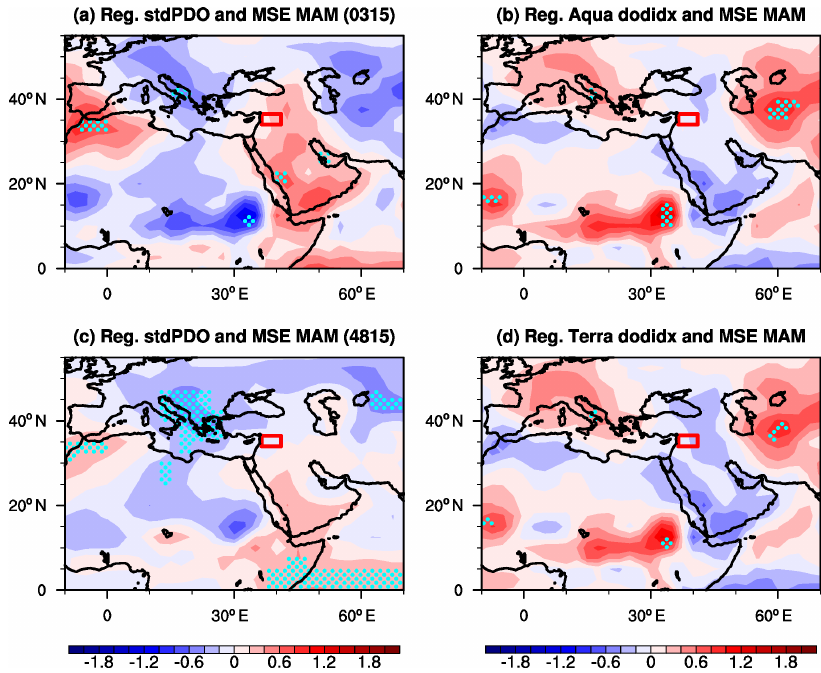
Figure 9. Regression of vertically integrated MSE (10 4 Jm − 2 ) over the lowest four atmospheric layers (1000, 925, 850, and 700hPa) from the NCEP1 onto the standardized PDO index for (a) 2003–2015 and (c) 1948–2015 and onto the standardized DOD indices from MODIS (b) Aqua and (d) Terra during 2003–2015. Areas significant at the 90% confidence level ( t test) are